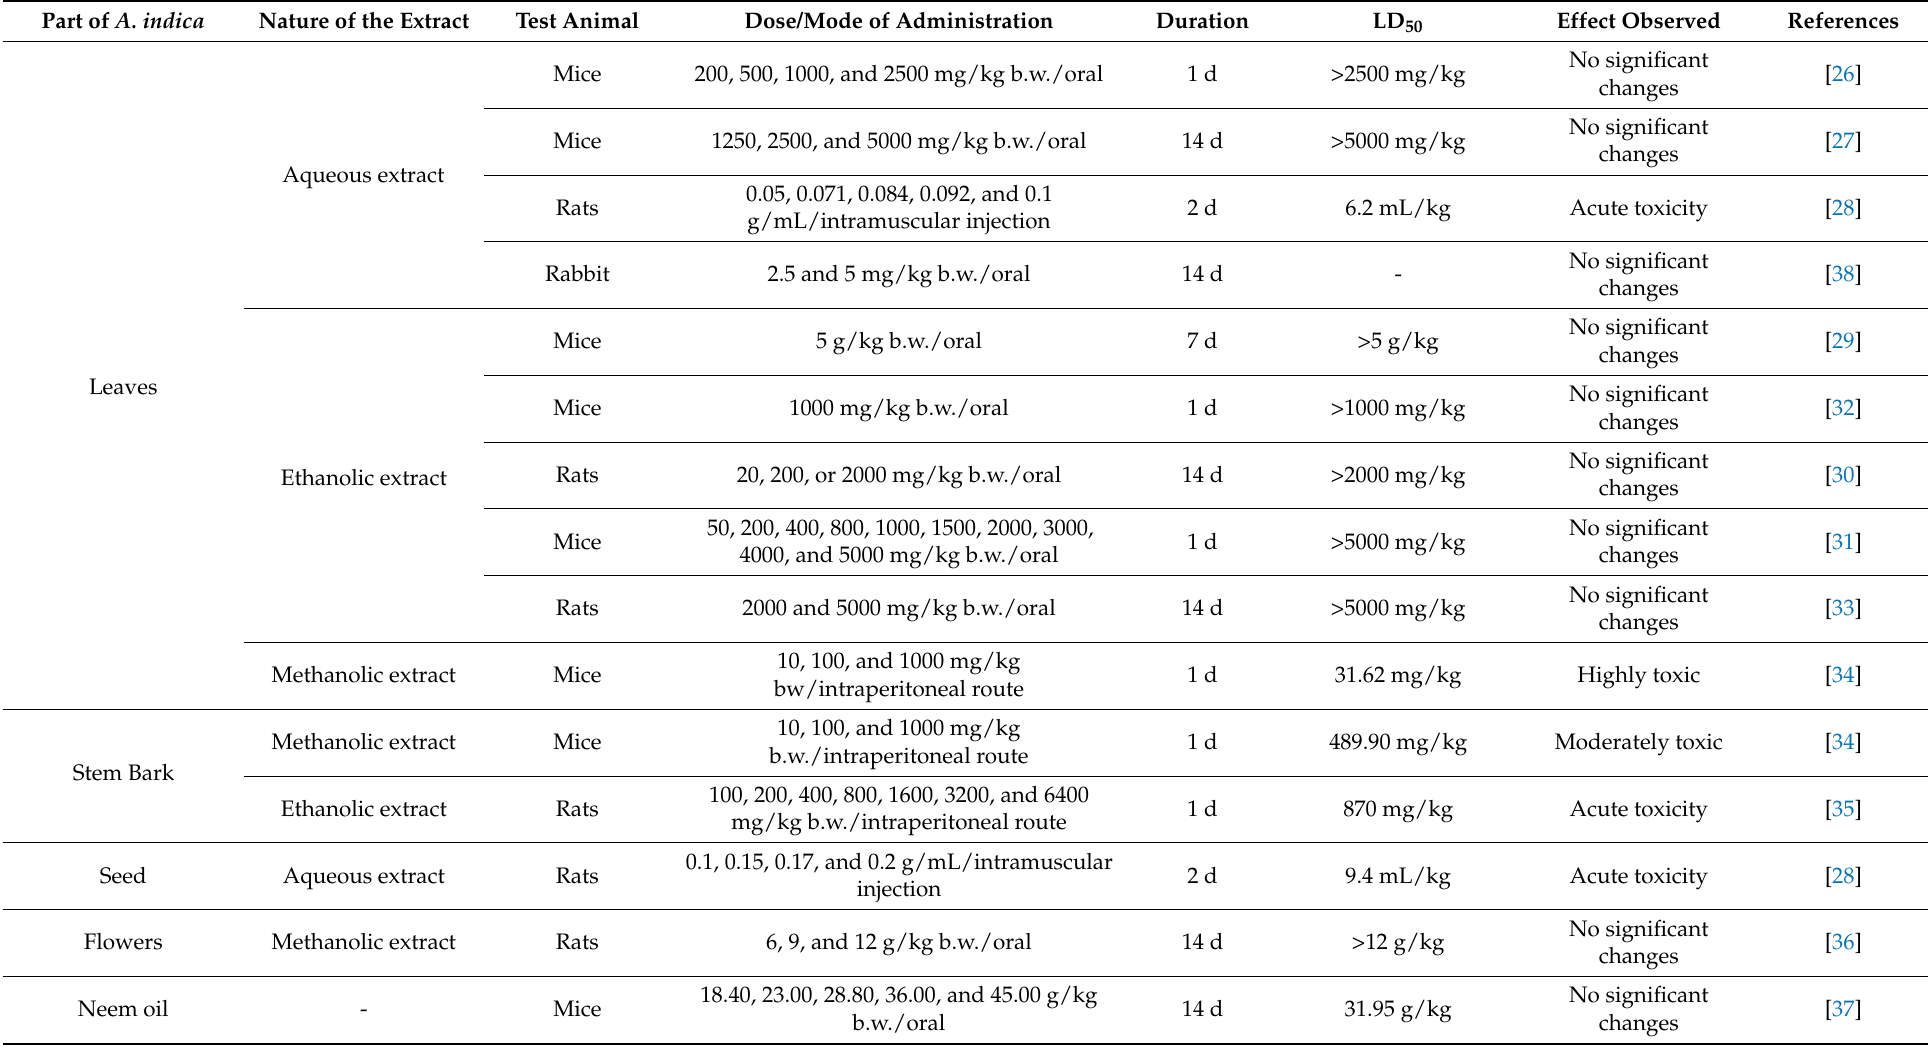
Table 2. Acute toxicity of neem in different